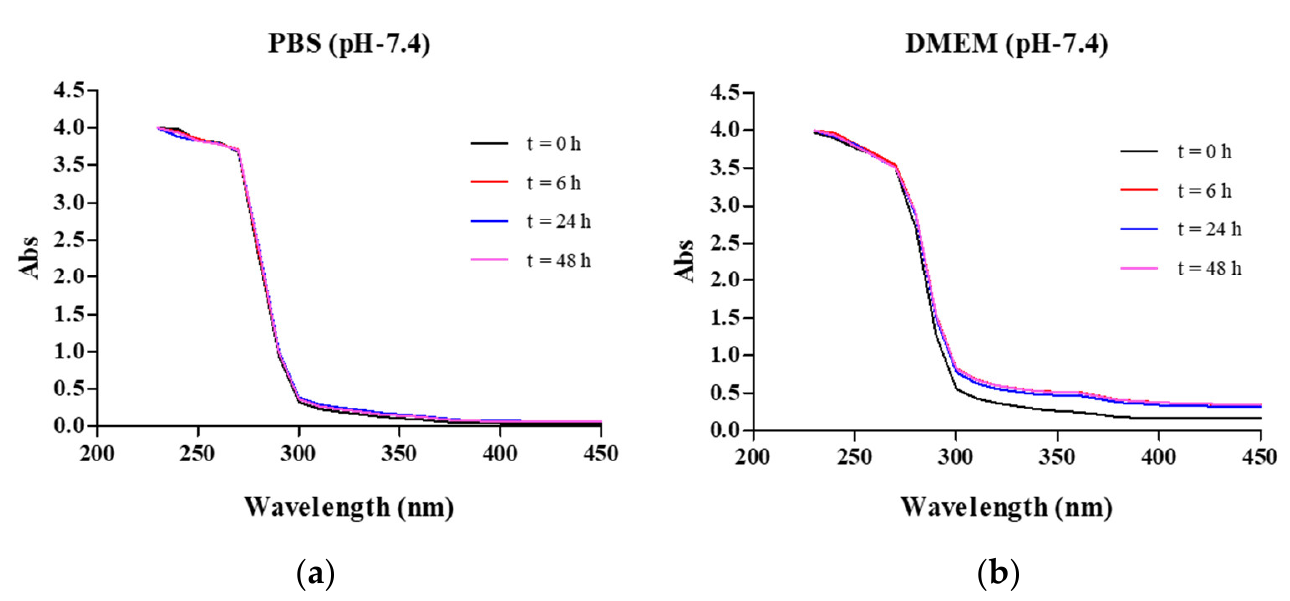
Figure 1. The FTIR spectrum of the Schiff’s base ligand ( L ) and transition metal complexes. The FTIR spectra indicated the presence of a C=N stretching vibration at 1634 cm − 1 for the ligand ( L ) and a C=N stretching vibration downshift to 1600–1617 cm − 1 , showing the coordination of Schiff bases and metal ions.